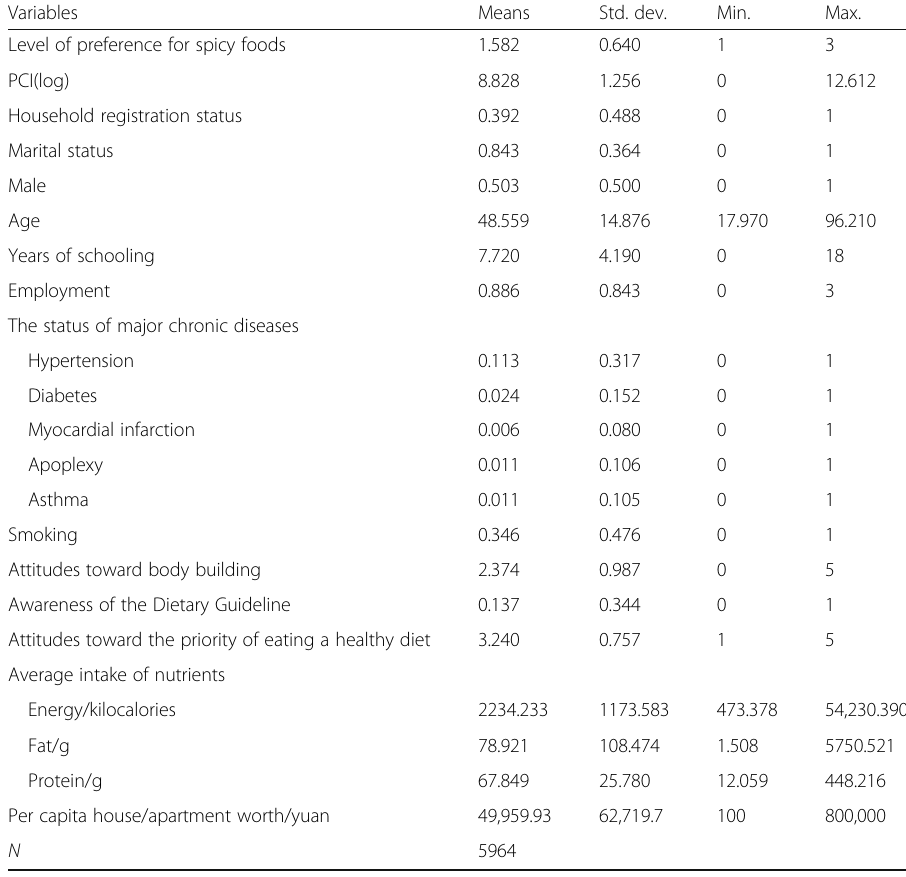
Table 2 Summary